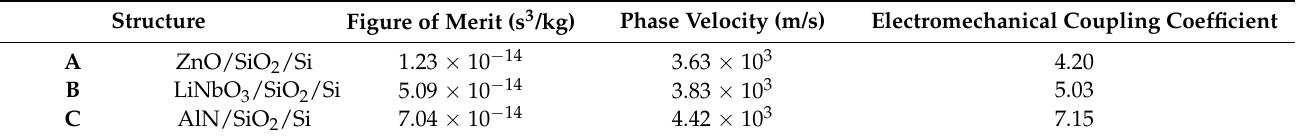
Figure 8. Electromechanical coupling coefficient ( k 2 ) versus normalised thickness of SiO 2 on different normalised thicknesses of ( a ) ZnO ( b ) LiNbO 3 ( c ) AlN. Table 4. AOFM, acoustic phase velocity and k 2 of structures A, B and C (with thickness 0.4 µ m for SiO 2 , ZnO, LiNbO 3, and AlN